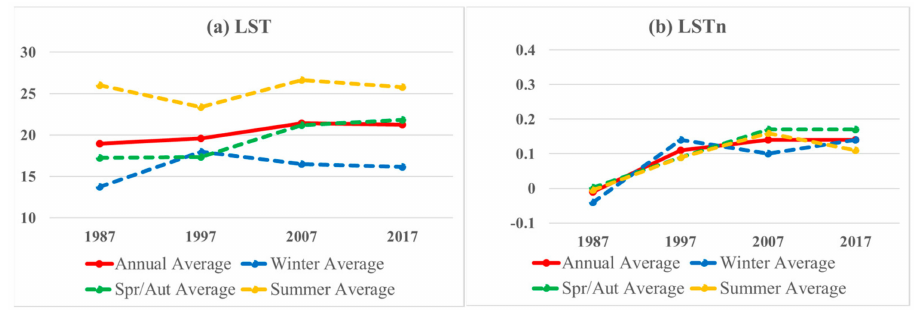
Figure 5. Annual and seasonal averages of ( a ) LST, and ( b )